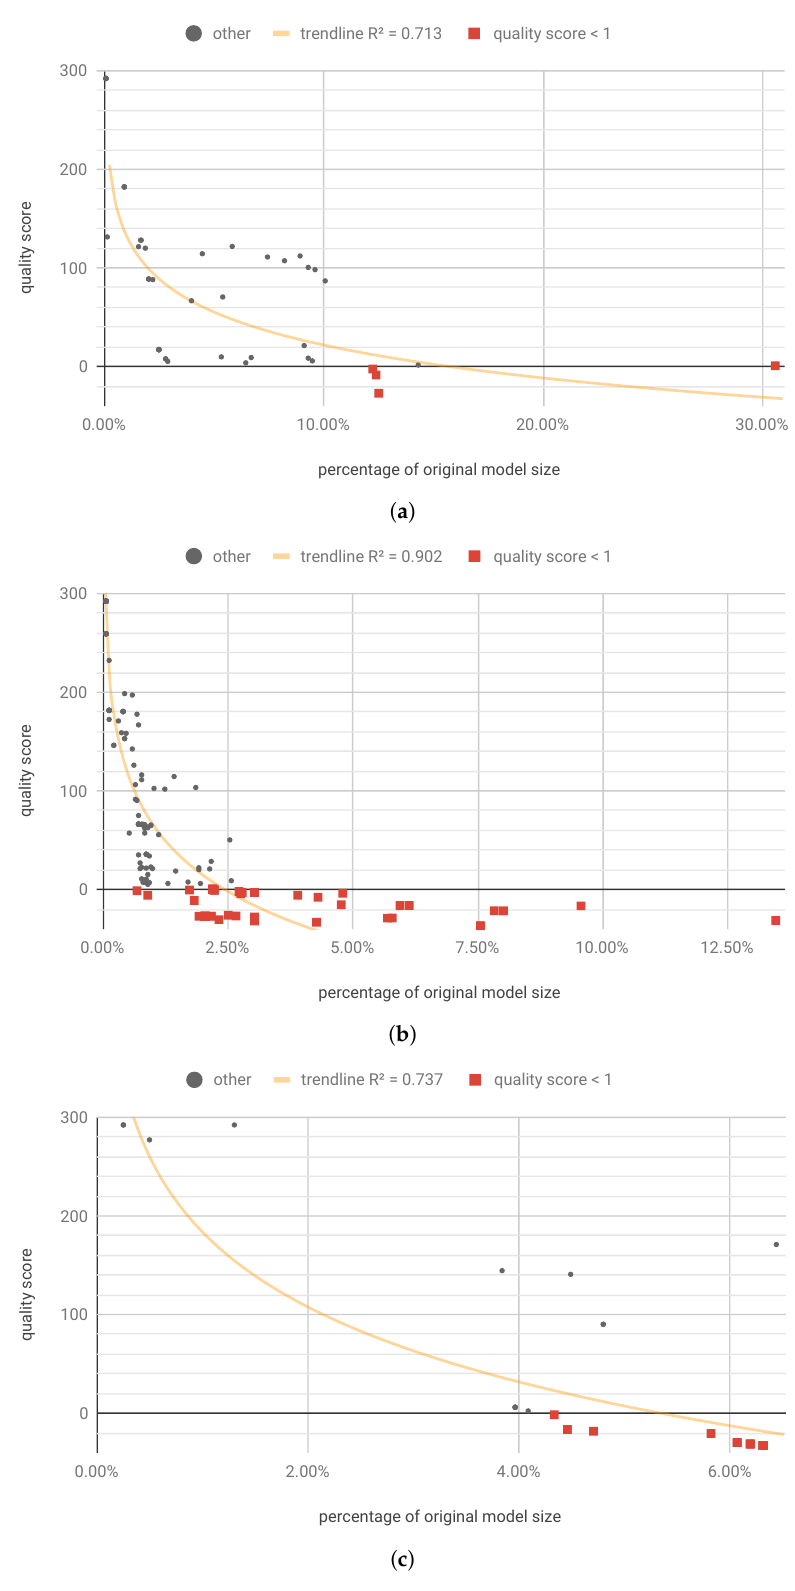
Figure 10. [IAP] Unique first Pareto front results. ( a ) Flow A: per-model pruning and quantization. trendline ( x ) = − 89.1 − 48.2ln x ; ( b ) Flow B: individualized pruning and quantization. trendline ( x ) = − 275 − 74ln x ; ( c ) Flow C-A: pruning and quantization with single retraining epoch. trendline ( x ) = − 320 − 109ln x